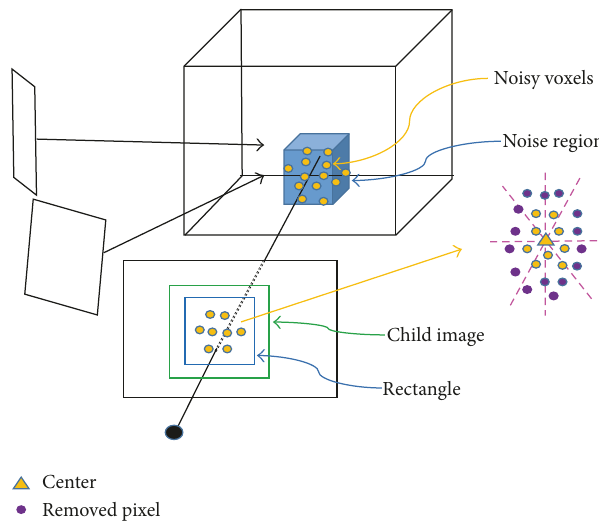
Figure 4: Generate and adjust a priori constraint for Grabcut, yellow points on the images label the a priori foreground pixels, green rectangle is the child image tailored from color images, and the pixels out of blue rectangle are a priori background pixels. On the right shows the operation in which we remove some a priori foreground pixels which are far from the center along several